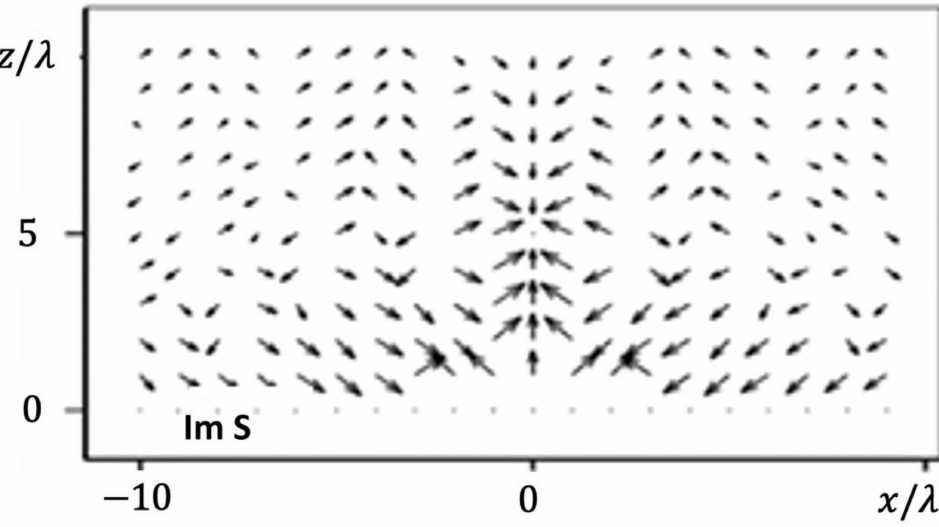
Figure 5. Spatial distribution of the imaginary part of the Poynting vector in a lossless environment: antenna length, 10 wavelengths; focus, ( 0, 5 λ ) ; amplitude distribution,